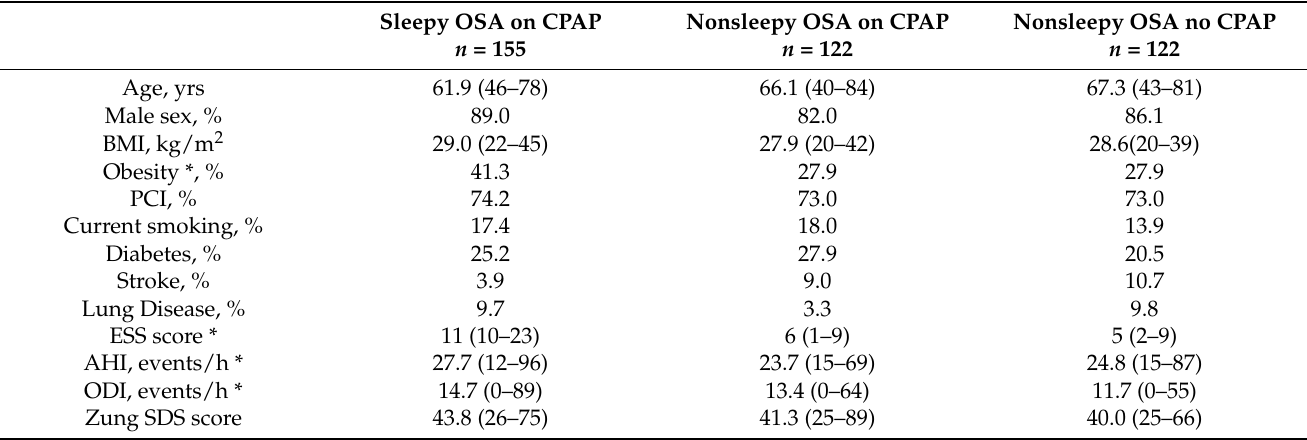
Table 2. Baseline characteristics of the study